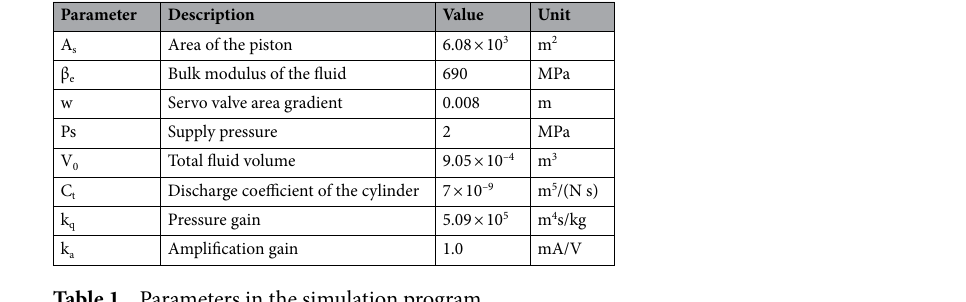
Table 1. Parameters in the simulation